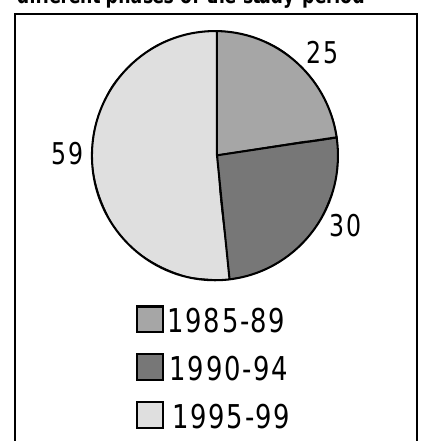
Figure 1: Number of projects in the different phases of the study period